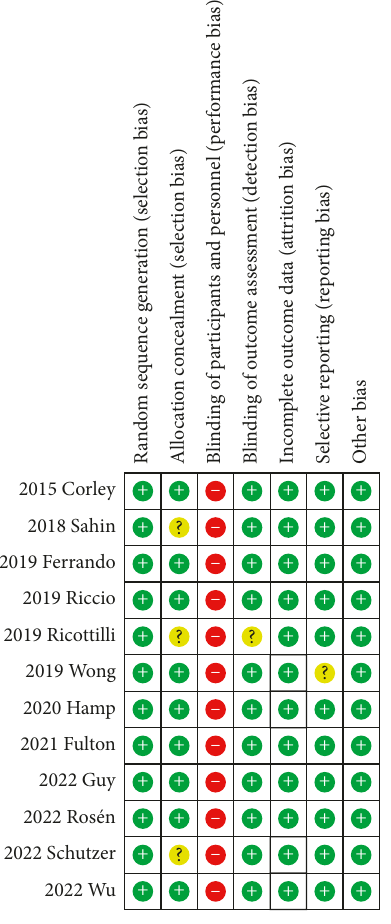
Figure 3: Summary of risk of